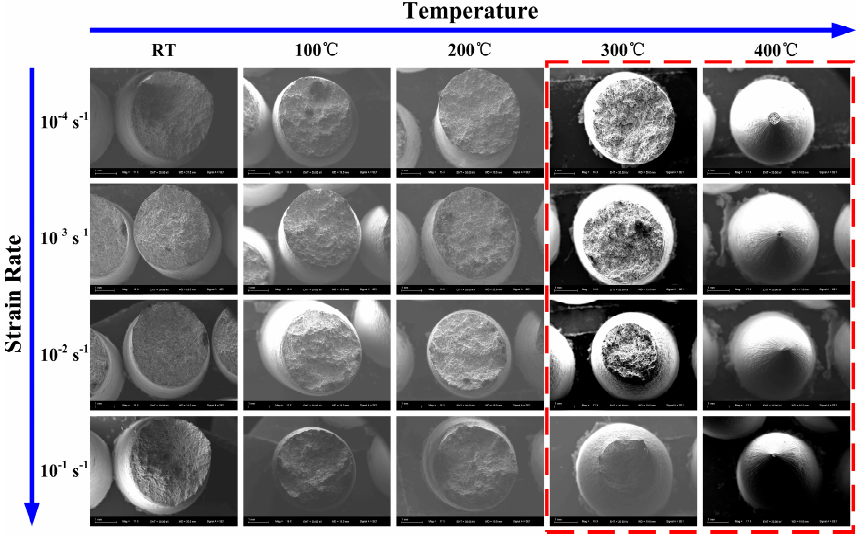
Figure 9. Fracture surface of specimens at various temperatures (RT—400 °C) and strain rates (10 − 1 –10 − 4 s − 1 ).